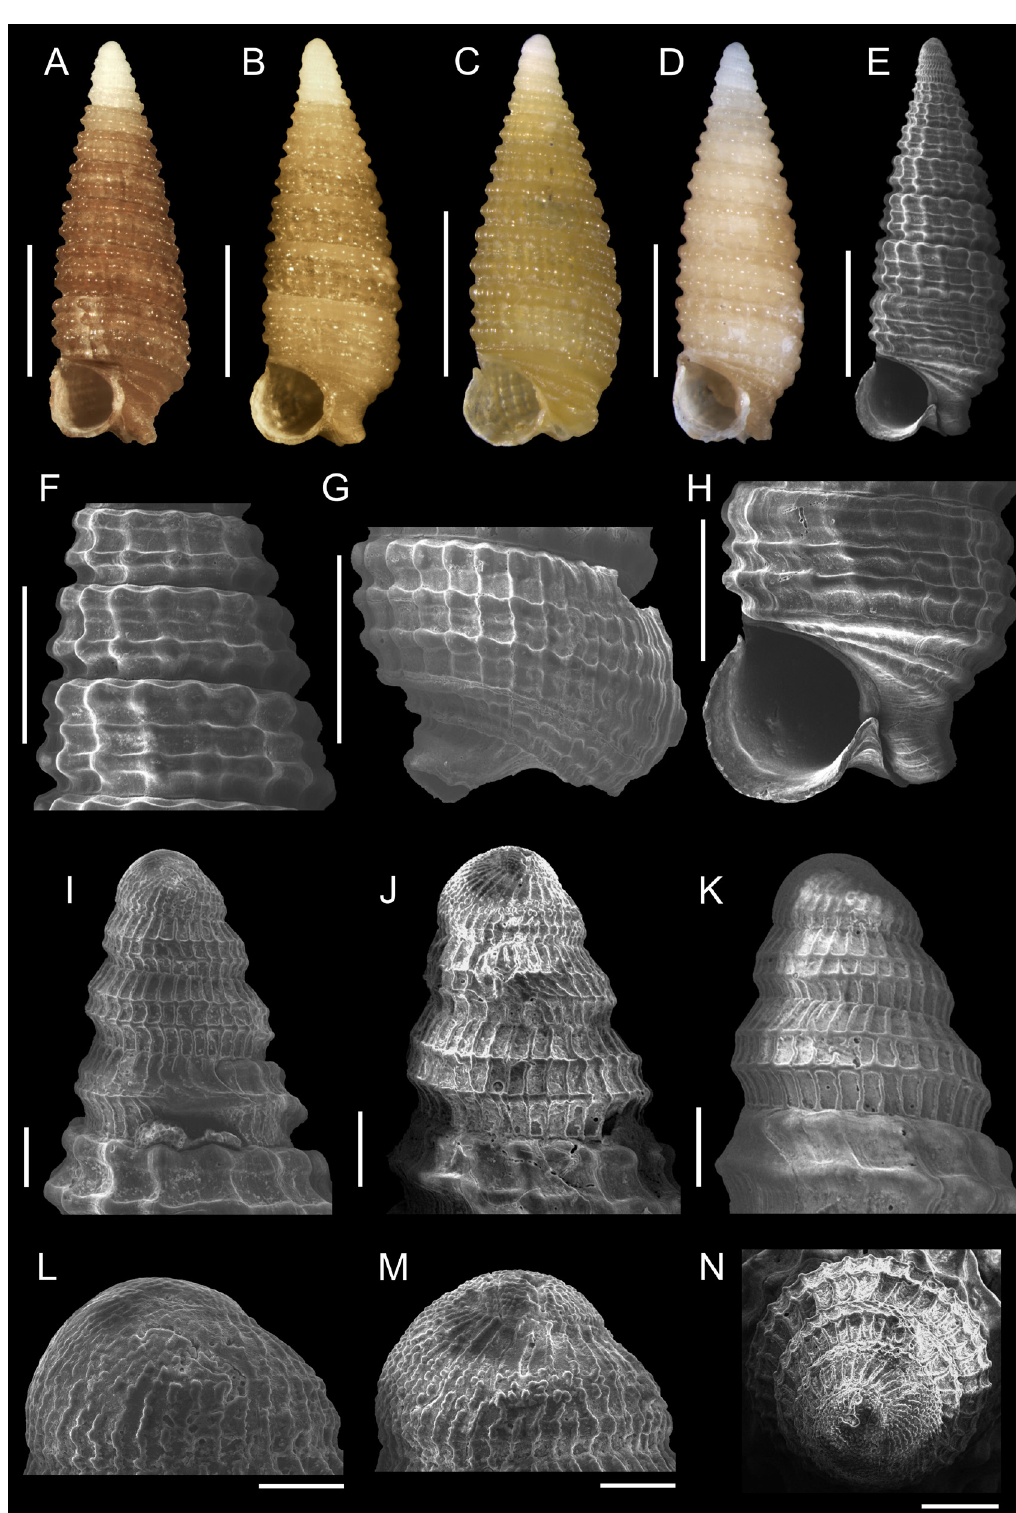
Fig. 13. Sagenotriphora albocaput sp. nov. A . MNRJ 29393*, holotype, 2.84 mm. B . MNRJ 29394*, 3.00 mm. C . MORG 20634*, 2.49 mm. D . MNRJ 32580*, 2.82 mm. E–F, H . Same shell as B. G, J, M–N . MNRJ 29395*. I, L . MNRJ 31652*. K . Same shell as D. Scale bars: A–E = 1 mm; F–H = 500 µm; I–K, N = 100 µm; L–M = 50